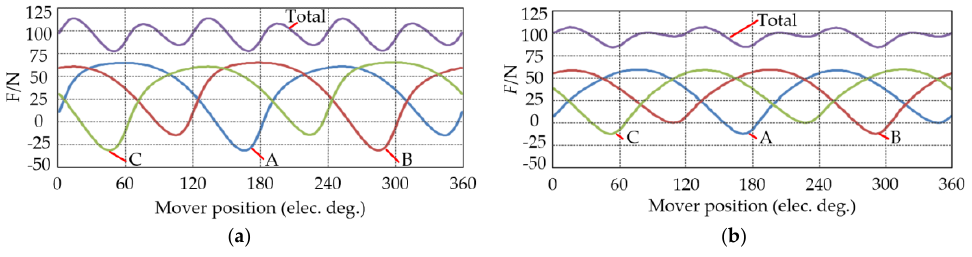
Figure 15. Iron core units: ( a ) The primary; ( b ) The secondary.